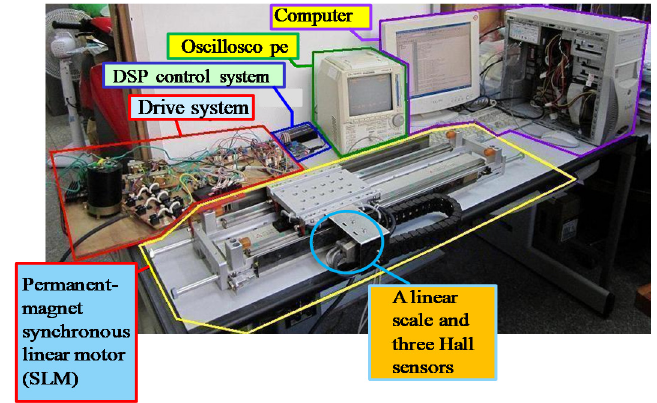
Figure 6. A photo of the experimental structure.